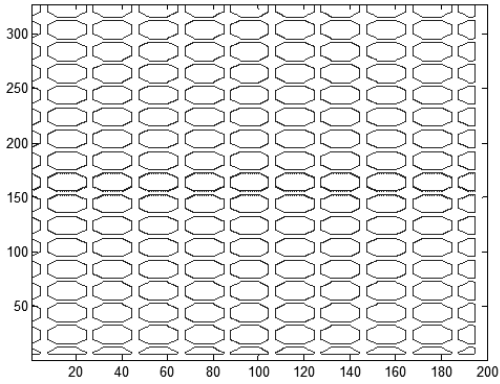
Figure 3. Initial contour.